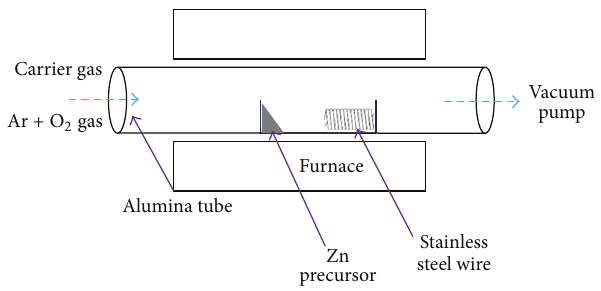
Figure 1: Schematic diagram of CVD system used to grow ZnO NRs.